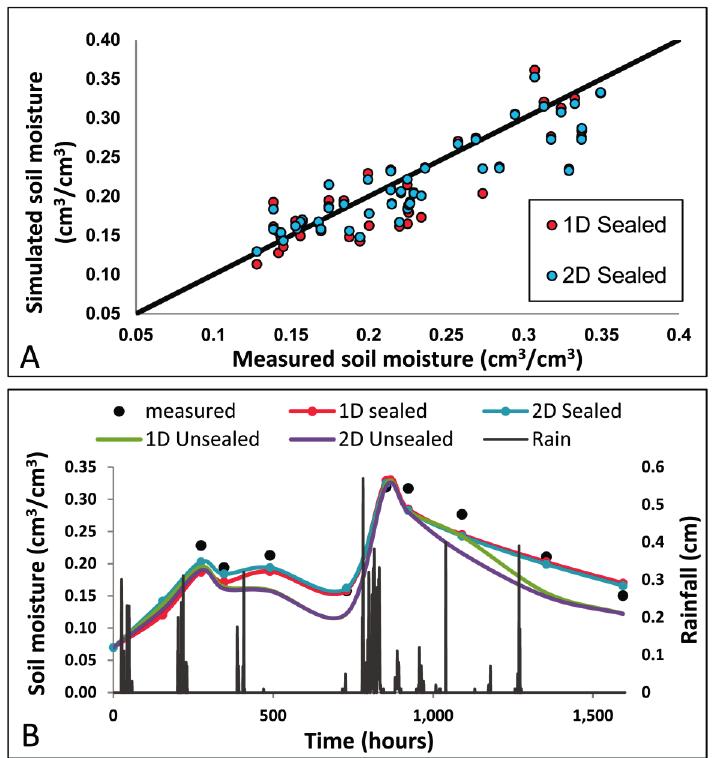
Figure A2. ( A ) Measured soil moisture data and the corresponding model predictions for a sealed system resulting from the application of the 1D and 2D approaches. ( B ) Mean values of the measured and simulated data throughout the 2010–2011 validation season, resulting from the application of the 1D and 2D approaches for both the sealed and unsealed